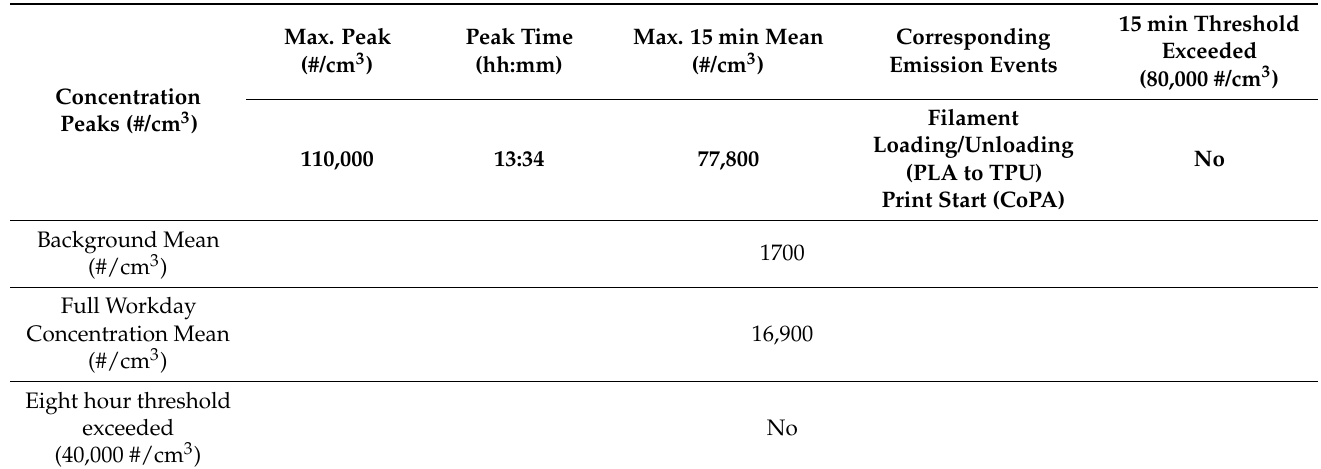
Table 3. Measurement Overview for Case 2—Comparison with exposure